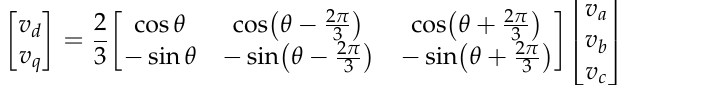
Figure 7. PLL model.